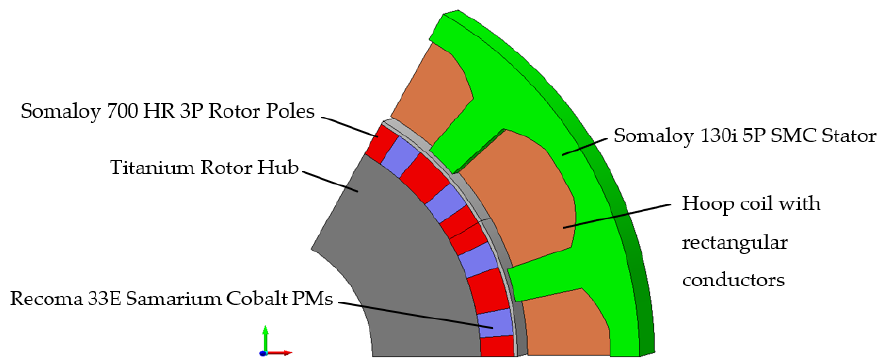
Figure 7. Final 3D TFM geometry with some mechanical design considerations (SMC stator include some curvatures and tapered teeth, required to compress the SMC powder at very high pressures).